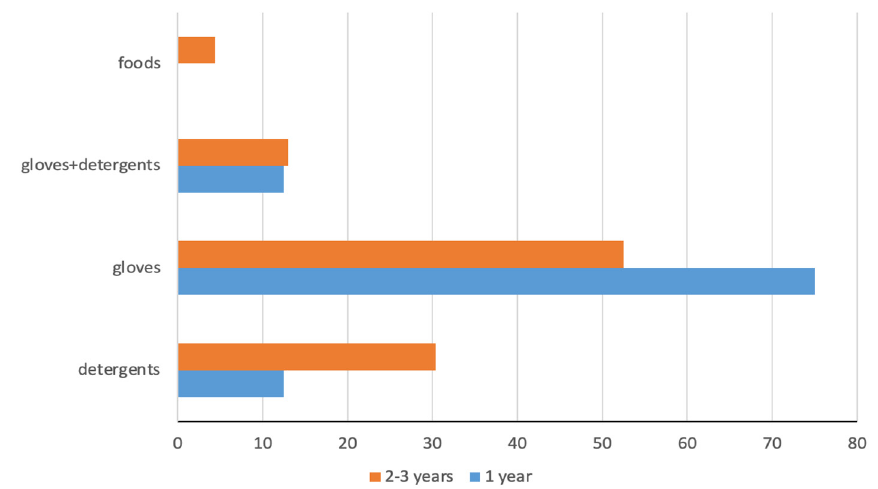
Figure 1. Substances that worsened HE.